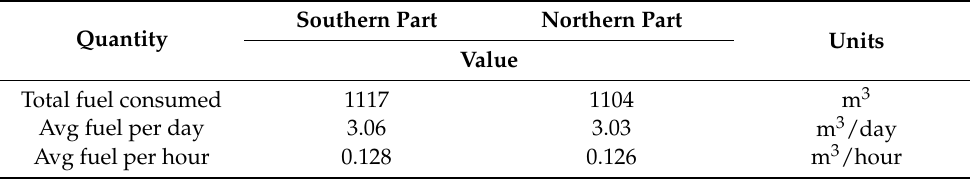
Table 2. Estimated fuel consumption for the generator in the northern and southern parts.